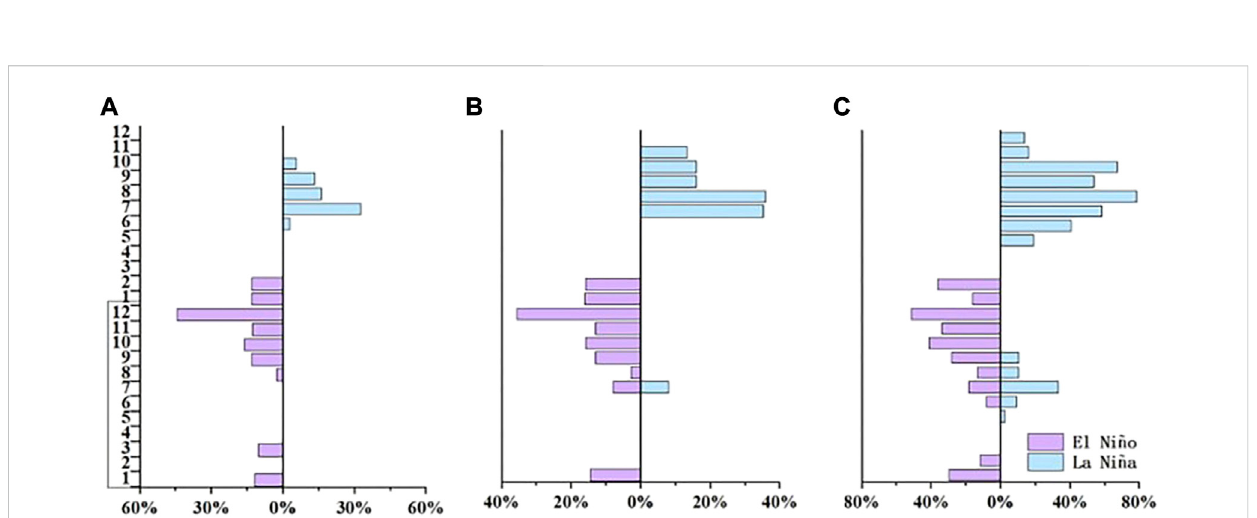
FIGURE 9 Percentage of the Weihe River basin, during El Niño/La Niña (boxed), and the following year, with signi fi cant drought areas in the 6-month SPI between (A) El Niño/La Niña and the remaining years and (B) El Niño/La Niña and normal years. (C) Percentage of the Weihe River basin with consistently negative anomalies among events during El Niño and La Niña